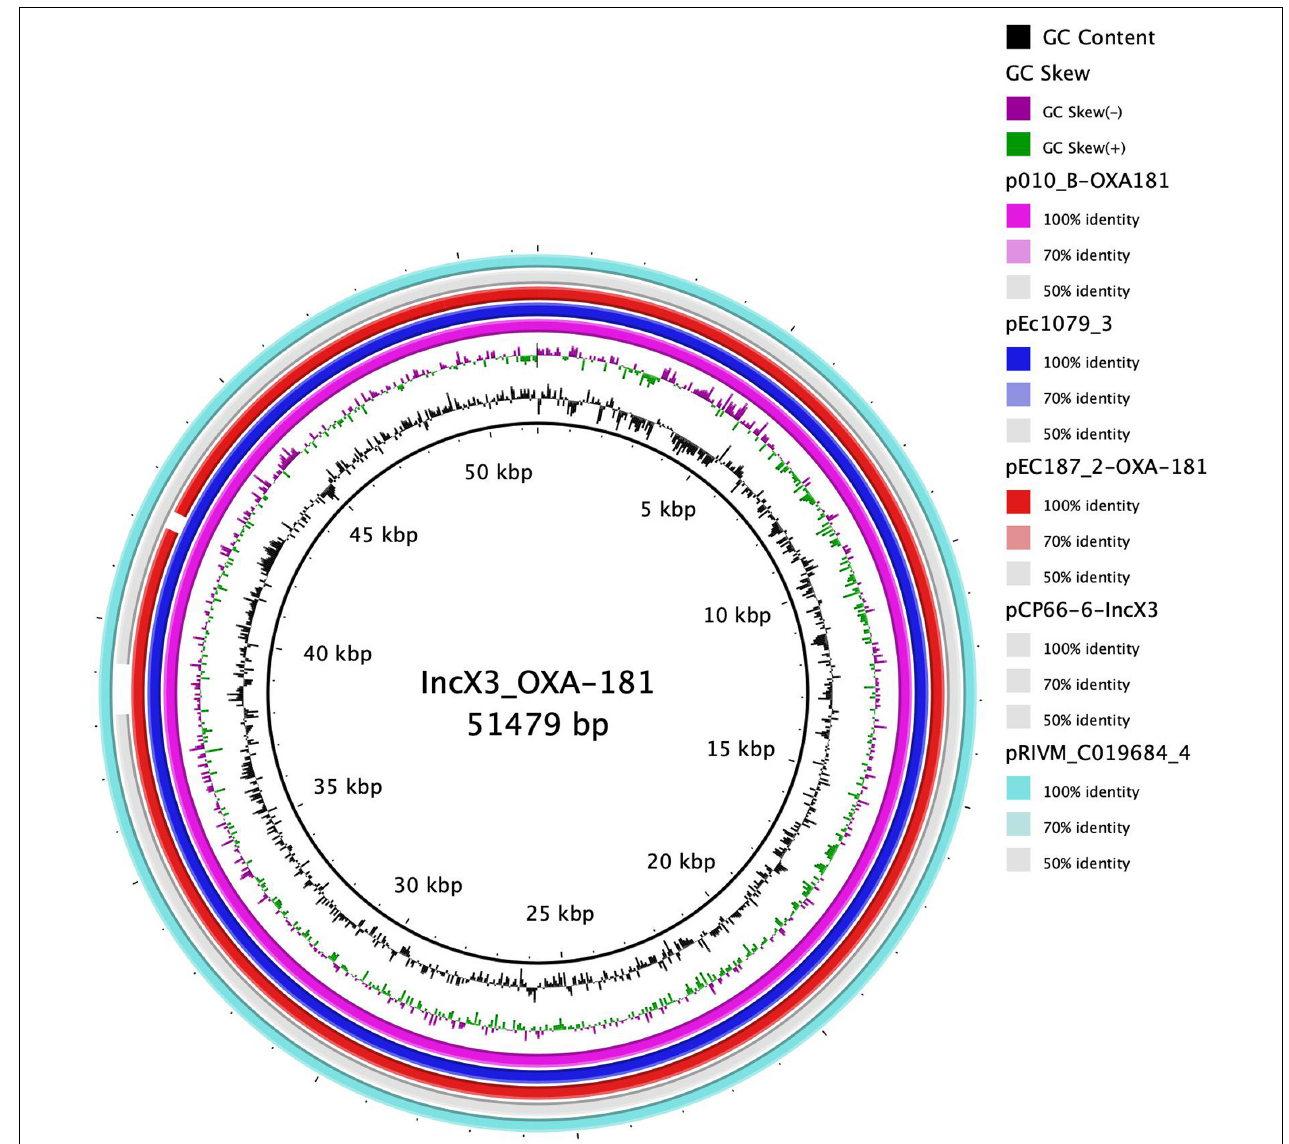
FIGURE 6 | Comparison of plasmid pEc1079_3 with other reported IncX3 plasmids. Figure was drawn using BRIG comparison tool. BRIG considers sequences with 50–70% similarity as identical. Rings are arranged from inside out starting with the reference sequence p010_B-OXA181 as pink, plasmid pEc1079_3 as blue, plasmid pEc187_2-OXA-181 as red ring, plasmid pCP66-6-IncX3 as gray, and plasmid pRIVM_C019684_4 as turquoise ring. White spaces between rings show sequences that are present in the reference but absent in the query sequences and the degree of